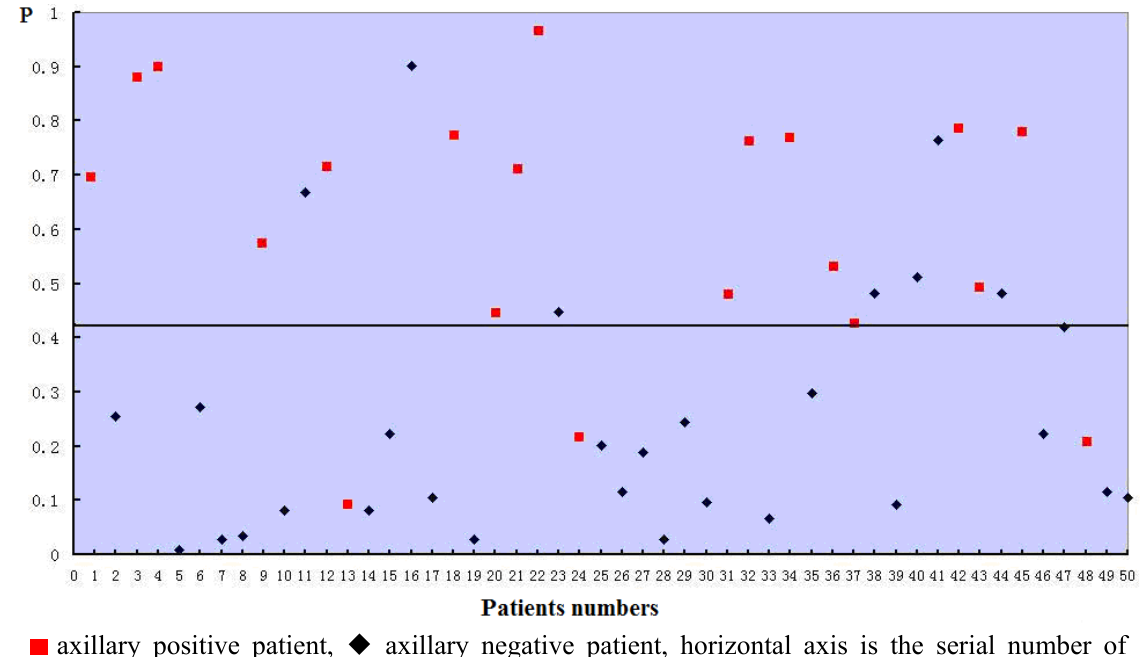
Figure 2. Logistic regression model Scatter diagram (n = 50).